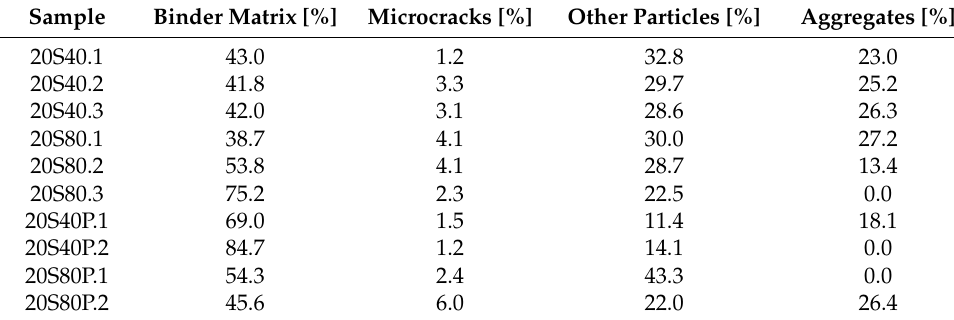
Table 5. Computed areas from SEM images.